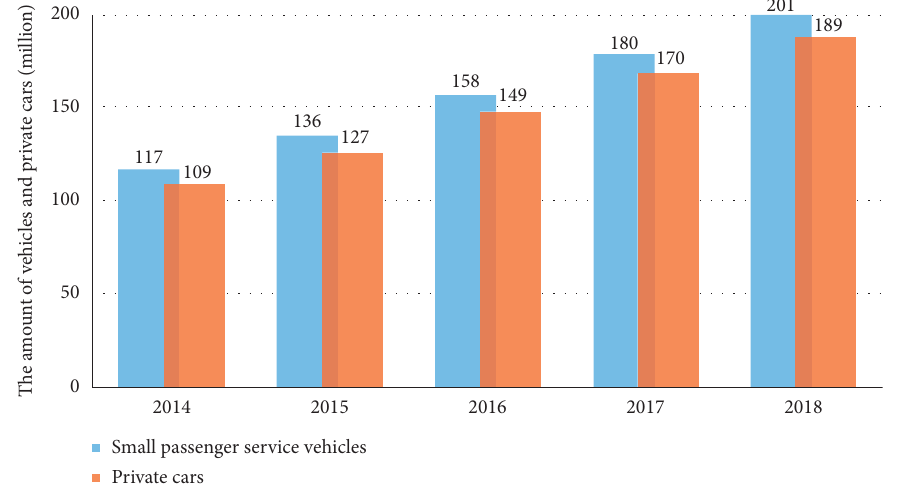
Figure 1: The amount of small passenger service vehicles and private cars in China in the past five years.